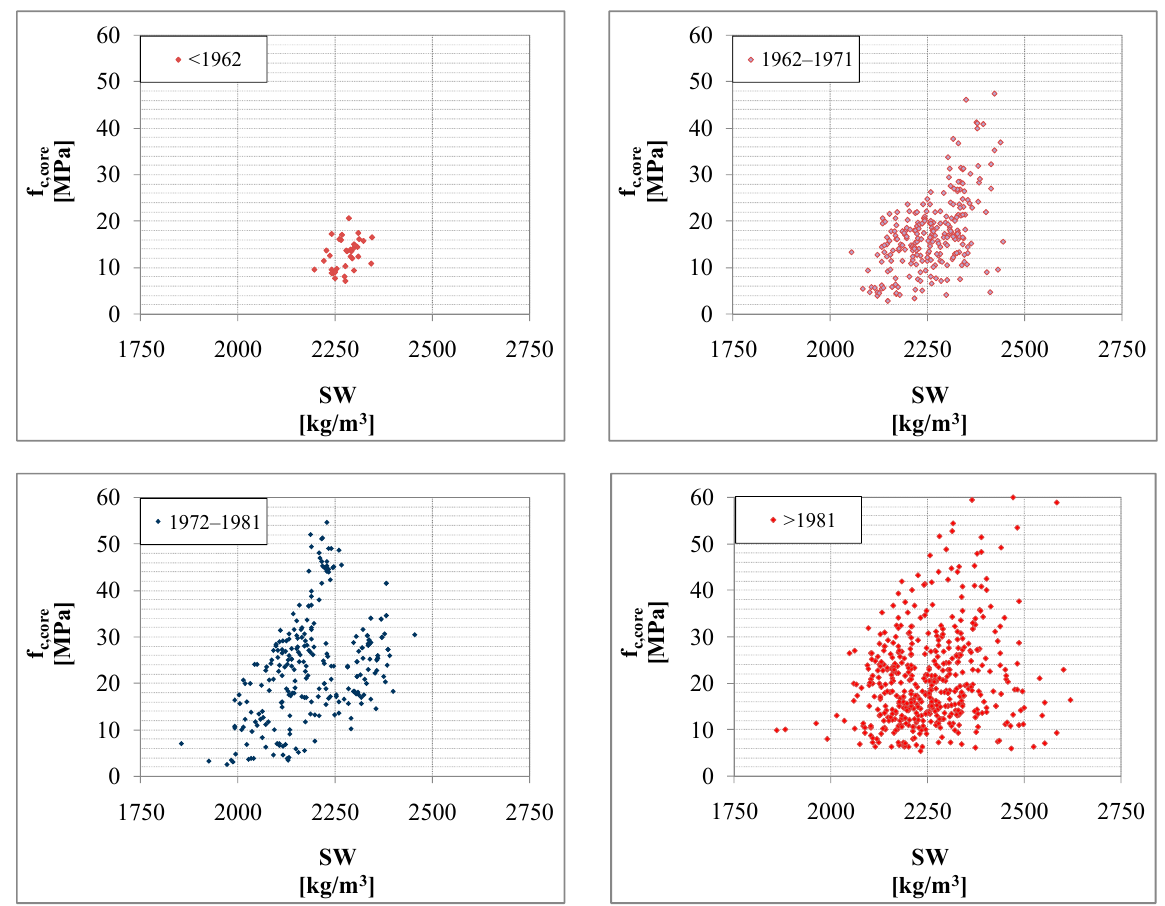
Figure 7. Correlation between Specific Weight (SW) and Compression Resistance of the samples, for